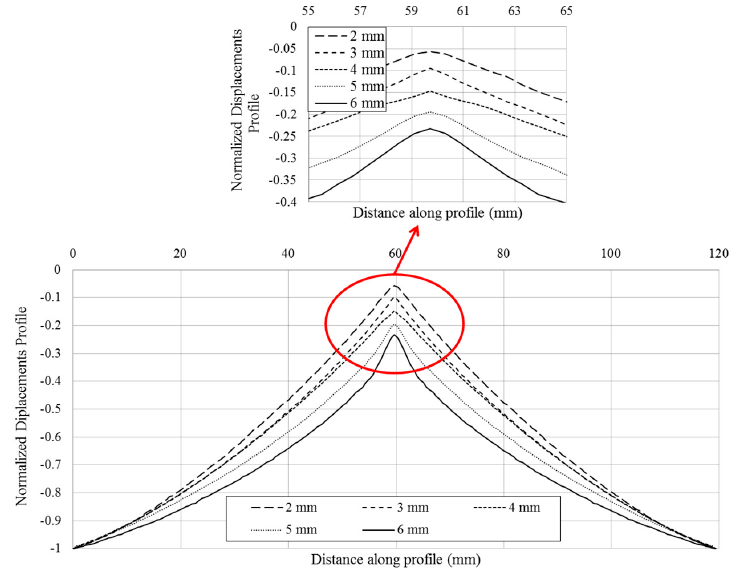
Figure 12. Normalized out of plane displacements profile by − 2 mm cylinder movement versus distance along profile for different specimen thickness (2, 3, 4, 5 and 6 mm).